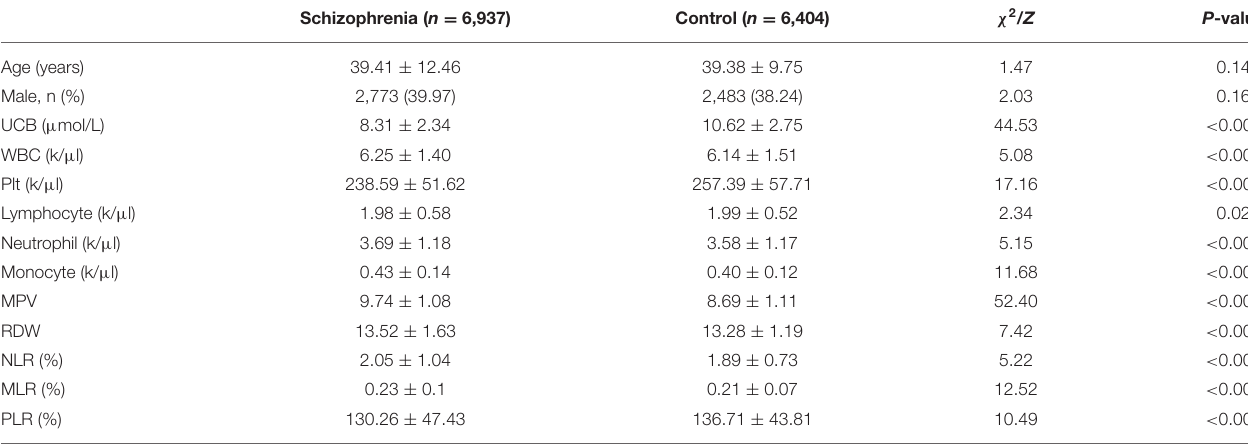
TABLE 1 | Baseline characteristics of the study population.